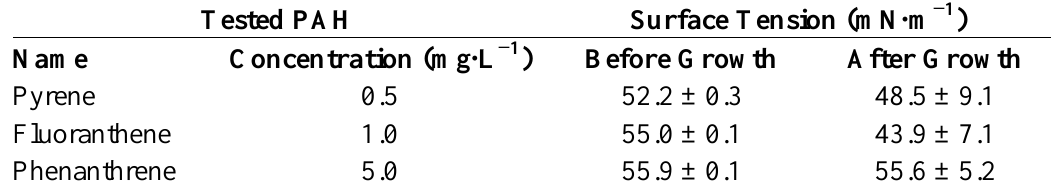
Table 1. Surface tensions and associated standard deviations of P. fluorescens